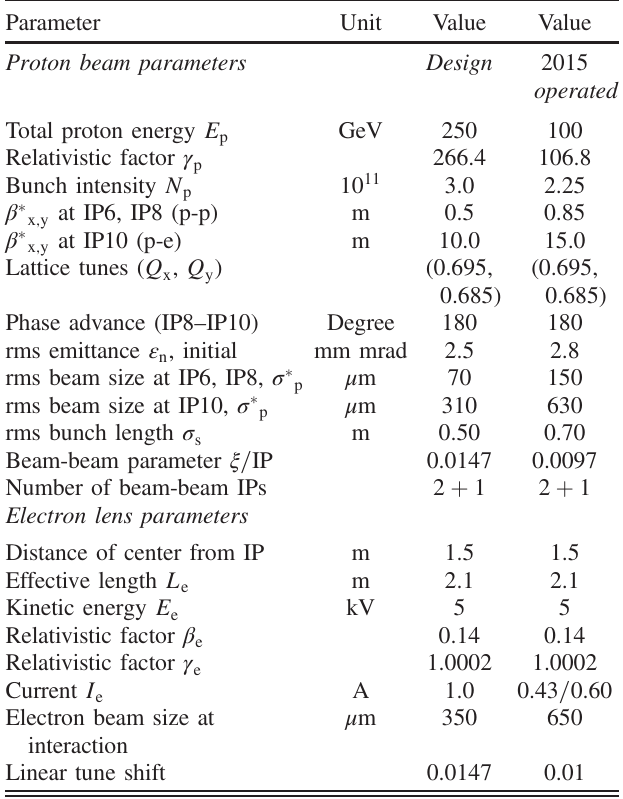
TABLE I. The parameters for the RHIC electron